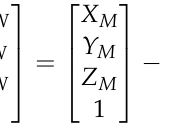
world coordinate system coordinate origin on the Y - and Z - axes, respectively. The transformation from the world coordinate system to the pixel coordinate system goes through the camera coordinate system and the image coordinate system, and the relationship between them is shown in Figure 5. The point P ( X W , Y W , Z W ) in the world coordinate system corresponds to the point p ( x , y ) in the image coordinate system. The Z C -axis of the camera coordinate system coincides with the z -axis of the image coordinate system, and the intersection O of the Z C -axis of the camera coordinate system and the imaging plane is used as the coordinate origin of the image coordinate system, and the plane formed by the x - and y -axes of the image coordinate system is parallel to the X C O C Y C - plane of the camera. The origin O 0 of the pixel coordinate system uO 0 v is the upper left vertex of the imaging plane, the u -axis is parallel to the x -axis of the image coordinate system xOy , and the v -axis is parallel to the y -axis of the image coordinate